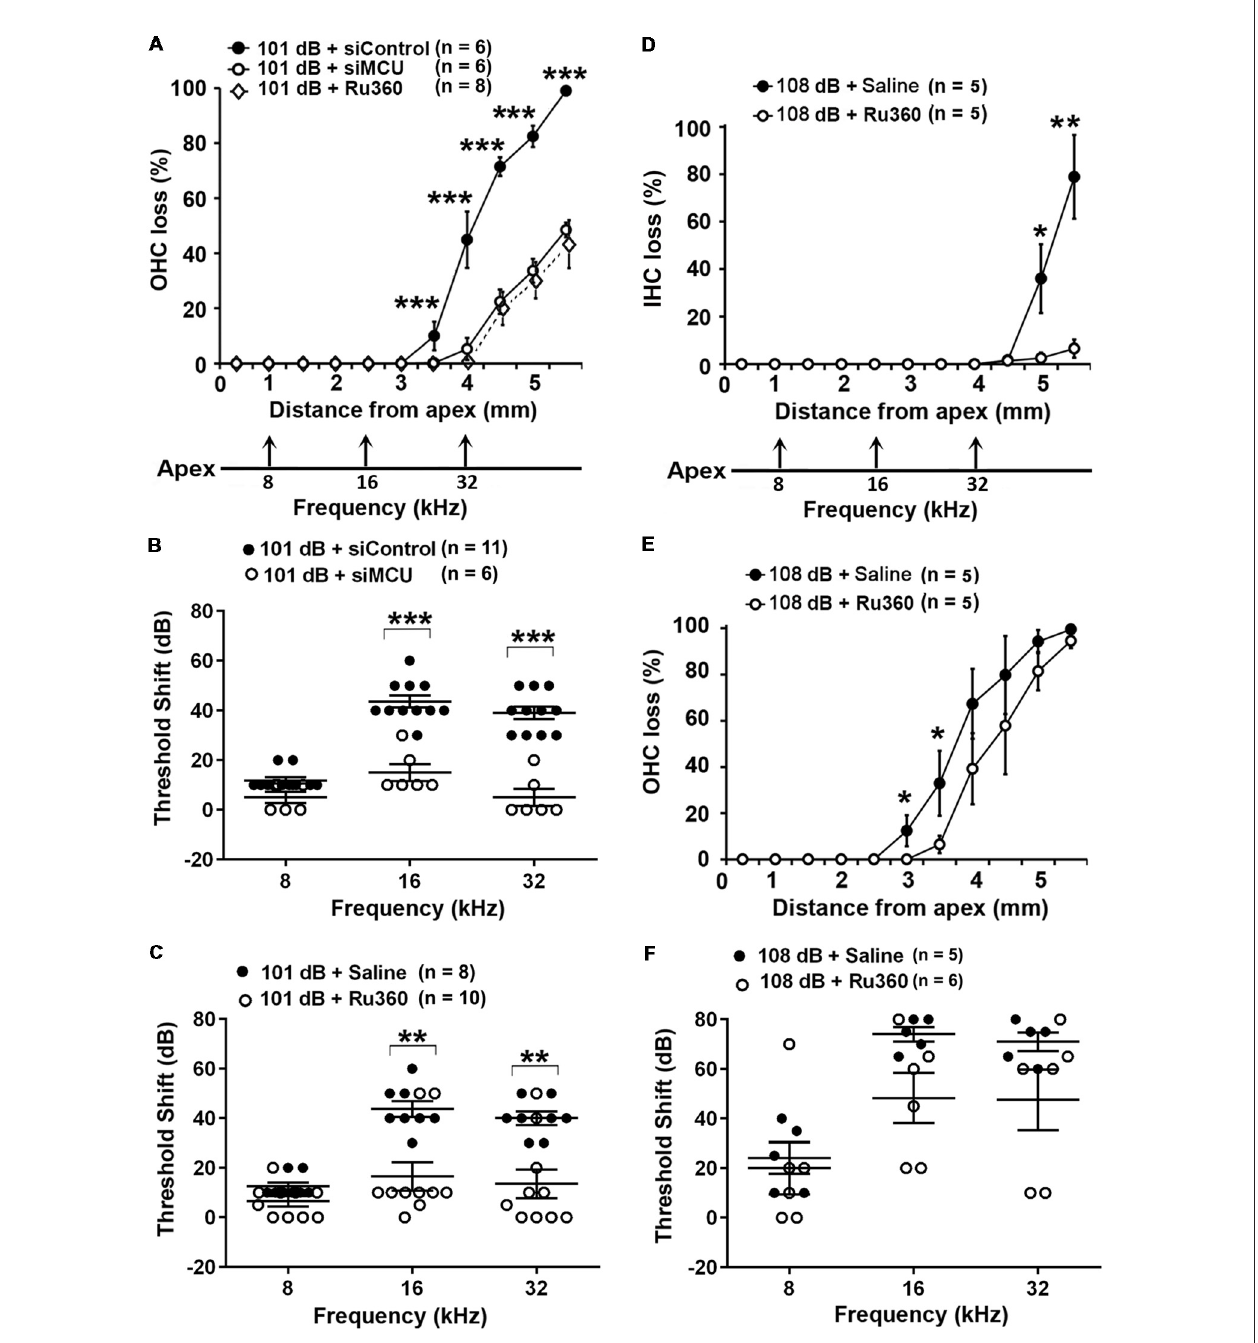
FIGURE 1 | Inhibition of mitochondrial calcium uniporter (MCU) via siRNA silencing or the pharmacological inhibitor Ru360 attenuated noise-induced hair cell loss and hearing loss. (A) Noise-induced outer hair cell (OHC) loss was reduced by siMCU pretreatment as well as by Ru360 treatment. The distance along the cochlear duct correlating with the frequencies of 8, 16, and 32 kHz is indicated. Data are presented as means ± SD; ∗∗∗ p < 0.001. (B) Pretreatment with siMCU attenuated 101-dB-noise-induced auditory threshold shifts measured 14 days after the exposure. Data are presented as individual points and means ± SD, ∗∗∗ p < 0.001. (C) Treatment with Ru360 also attenuated 101-dB-noise-induced auditory threshold shifts measured 14 days after the exposure. Data are presented as individual points and means ± SD, ∗∗ p < 0.01. (D) Treatment with Ru360 attenuated 108-dB-noise-induced inner hair cell (IHC) loss. The distance along the cochlear duct correlating with the frequencies of 8, 16, and 32 kHz is indicated. Data are presented as means ± SD, ∗ p < 0.05, ∗∗ p < 0.01. (E) Treatment with Ru360 attenuated 108-dB-noise-induced OHC loss at 3 and 3.5 mm from the apex. Data are presented as means ± SD, ∗ p < 0.05. (F) Treatment with Ru360 did not attenuate 108-dB-noise-induced auditory threshold shifts measured 14 days after the exposure. Data are presented as individual points and means ± SD, n in all figures indicates the number of mice per group; left cochlea was assessed per mouse.